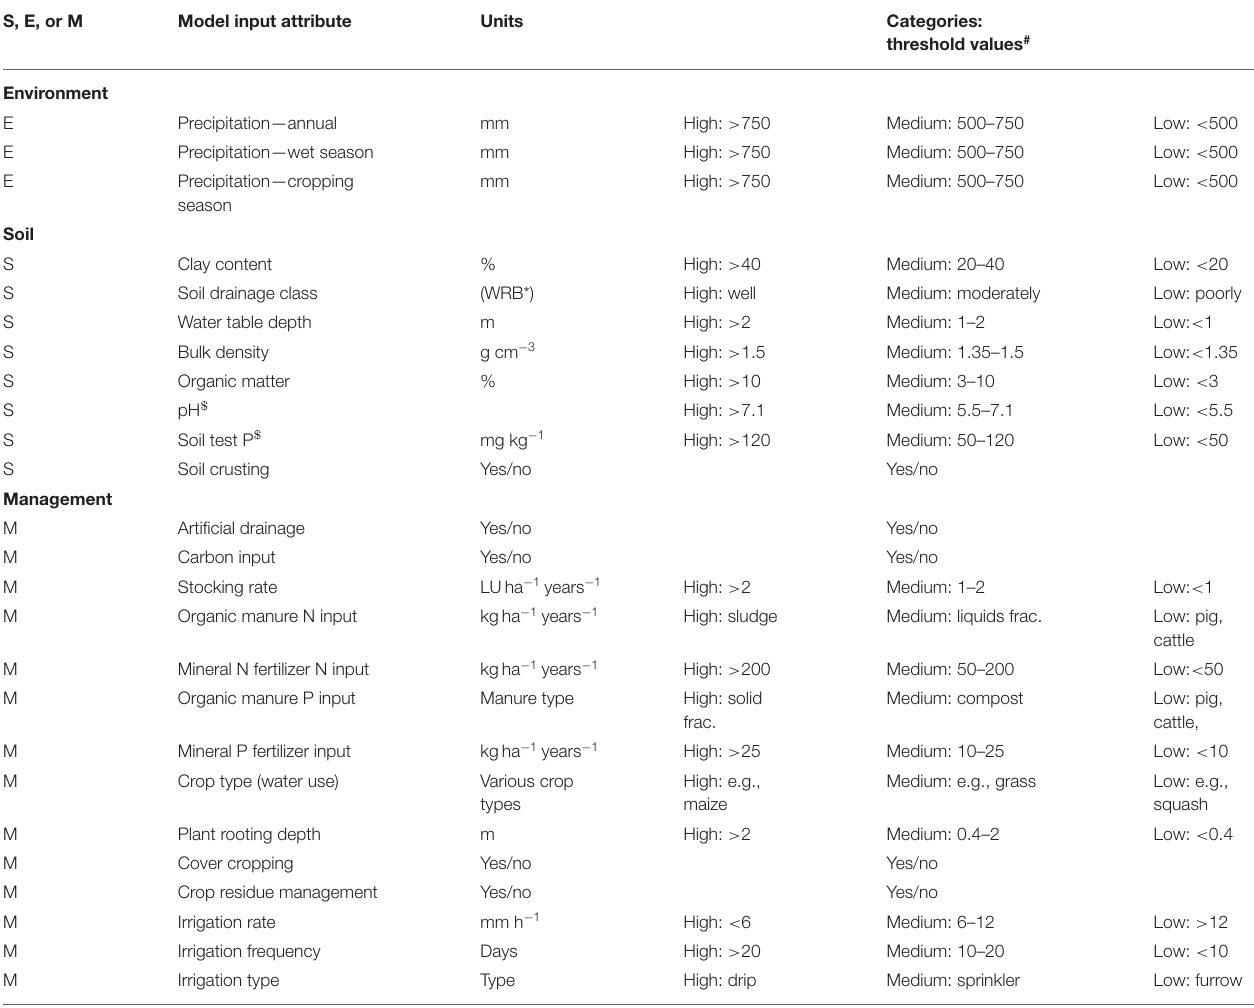
TABLE 1 | Thresholds used to categorize input attributes into “low,” “medium,” and “high,” or “yes” or “no.” S, E, or